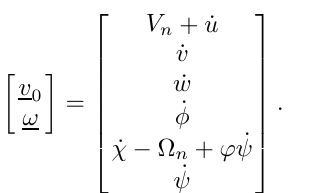
N. Bosso et al. / Dynamic behavior of a railway wheelset on a roller rig versus tangent